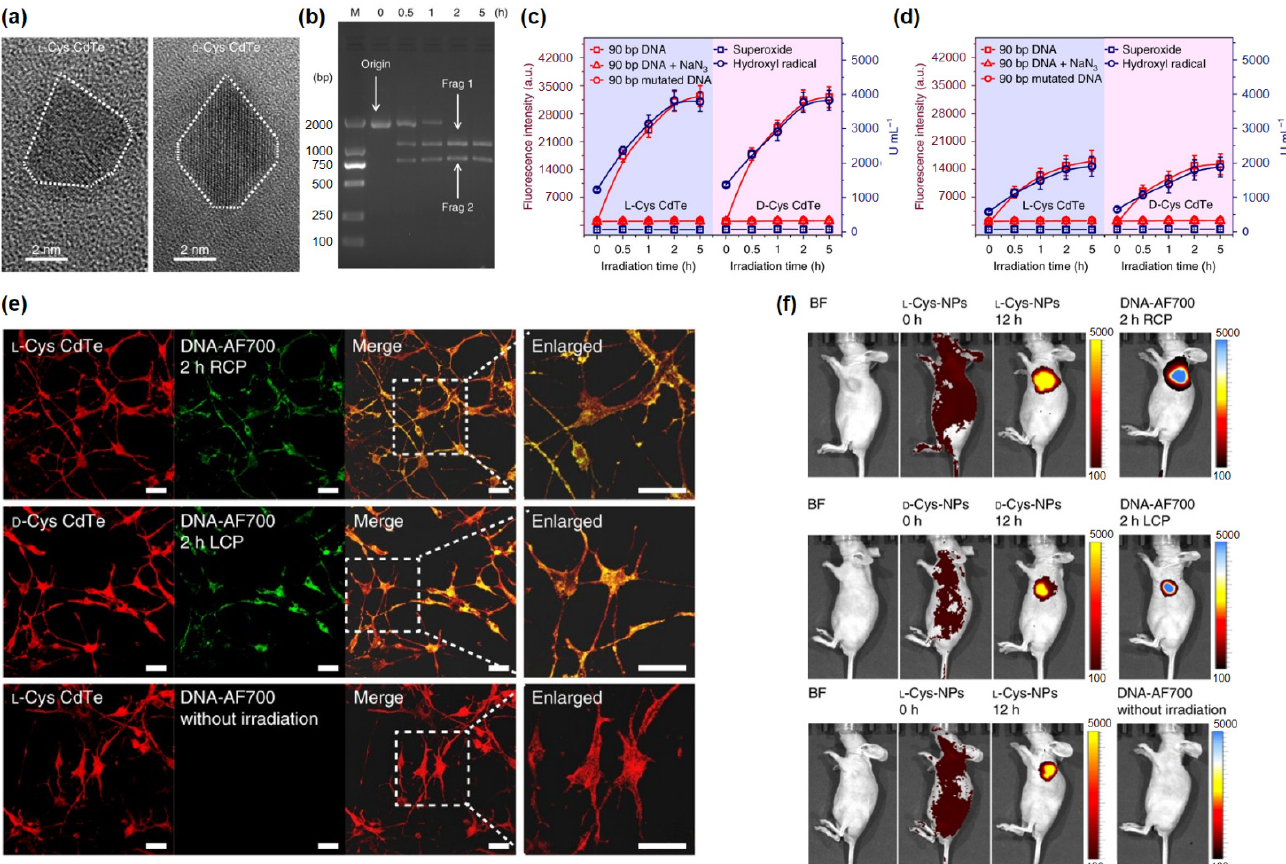
Figure 6. ( a ) TEM images of L- / D- Cys CdTe NPs. ( b ) Electrophoresis images of L- Cys CdTe NPs with 1839 bp DNA illuminated RCP for 2 h. The two DNA fragments after cleavage are denoted by frag 1 and frag 2. ( c ) ROS production with 90 bp DNA, mutated 90 bp DNA and 90 bp DNA with ROS inhibitor (NaN 3 ) in L- Cys CdTe NPs under RCP and D- Cys CdTe NPs under LCP. ( d ) ROS production in L- Cys CdTe NPs under LCP and D- Cys CdTe NPs under RCP. ( e ) Confocal images of neural stem cells incubated with L- / D- Cys CdTe NPs under RCP/LCP and without irradiation, scale bar = 20 µ m. ( f ) In vivo images of nude mice after L- / D- Cys CdTe NPs injected with irradiation under RCP/LCP for 2 h and without irradiation. Reprinted with permission from Ref. [23]. Copyright 2018 Springer